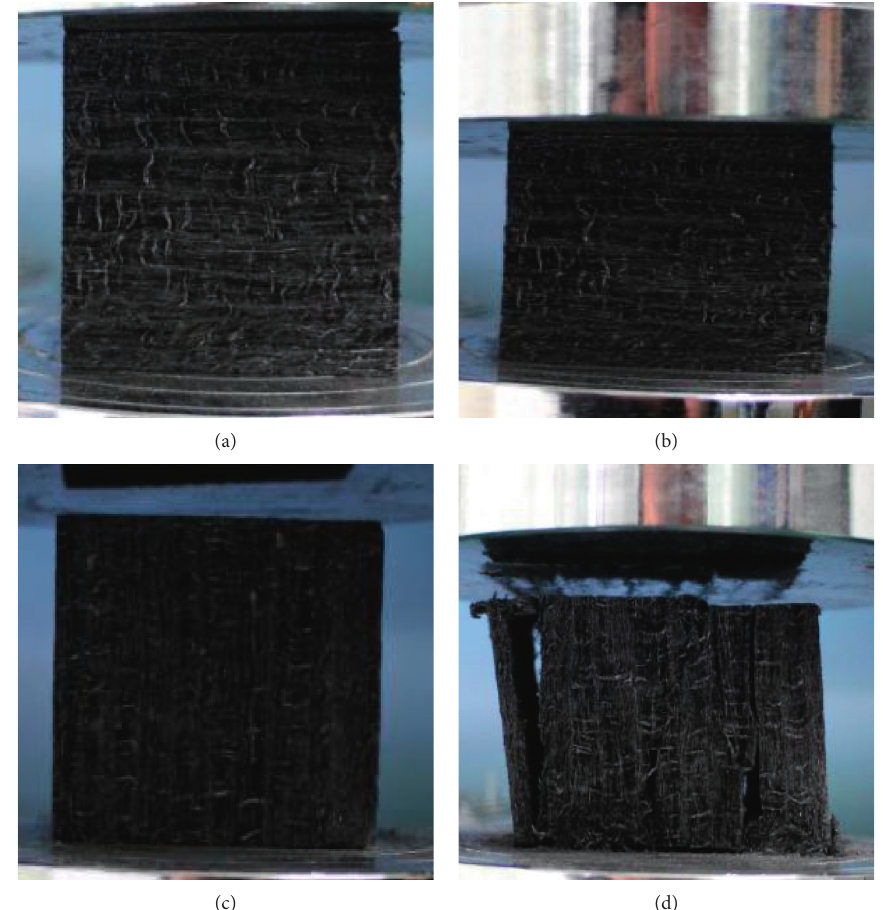
Figure 10: Compression failure process diagrams of carbon/carbon fiber composites: (a), (b) front compression ( Z direction); (c), (d) side compression ( X direction or Y direction).